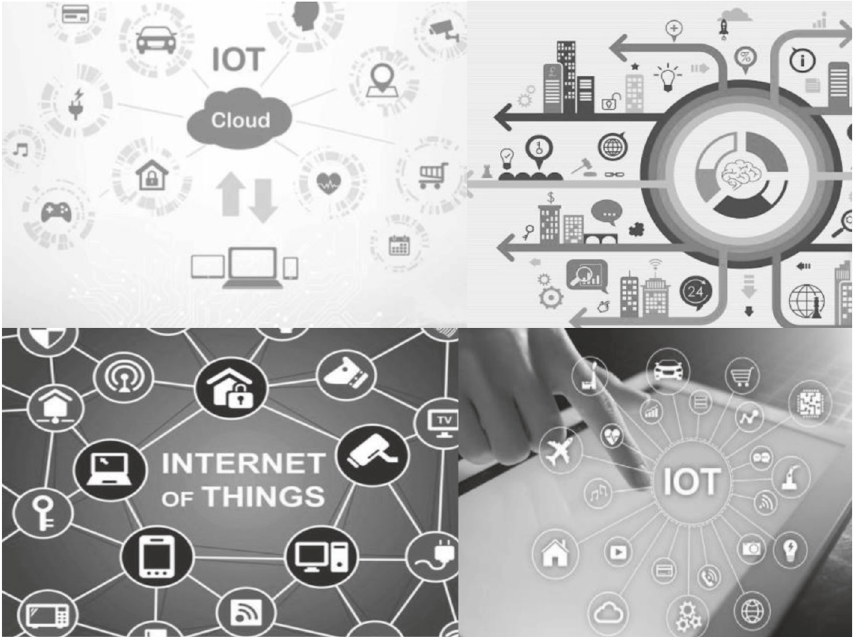
Figure 2: Applications of the internet of things.